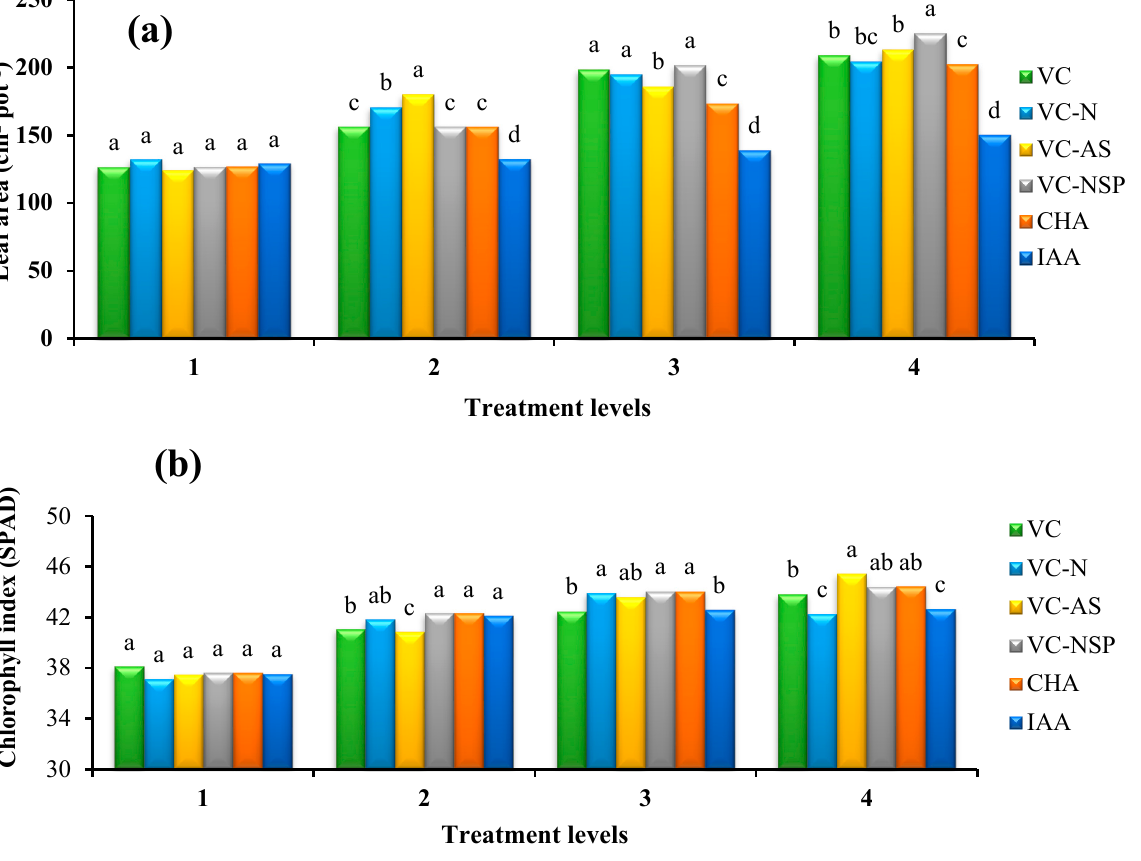
Figure 2. Comparison of average soil application of experimental treatments on leaf area ( a ) and chlorophyll index (SPAD) ( b ) at treatment levels (levels 1, 2, 3 and 4 for VC, VC-N, VC-AS and VC-NSP treatments of 0, 1, 2 and 3% VC, 0, 200, 400 and 600 mg of CHA per kg of soil and 0, 10 − 6 , 10 − 5 and 10 − 4 molar IAA). Different letters in each figure show significant difference at p ≤ 0.05 by Duncan multiple range test. VC, VC without enrichment; VC-N, VC enriched with 1% nitrogen; VC-NSP, VC enriched with 1% nitrogen, 1% sulfur, and 1% phosphorus; VC-AS, VC enriched with Azotobacter chroococcum (21Az) + Pseudomonas fluorescens (Ps 59); CHA, Commercial humic acid; IAA, Indole-3-acetic acid.